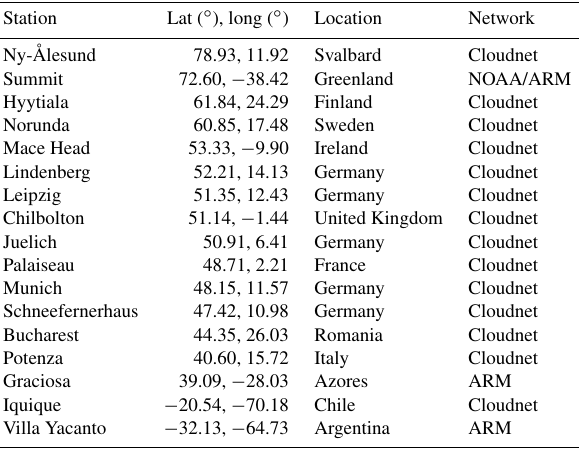
Table 3. Selection of Cloudnet and ARM sites considered in this